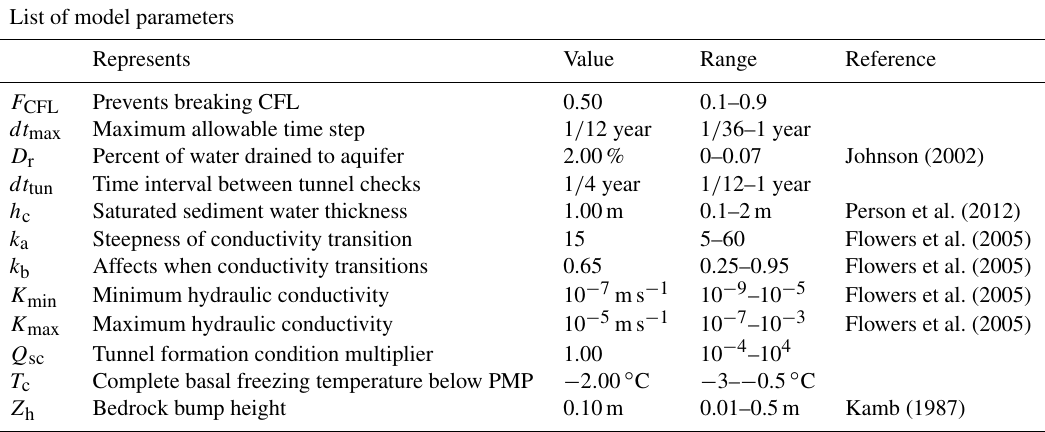
Table 2. Chosen values for the baseline model run for synthetic and North American test runs. List of model